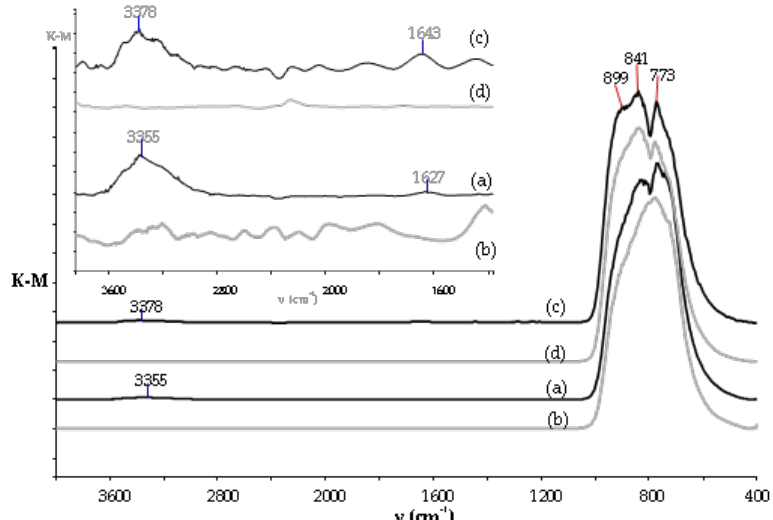
Figure 4. Infrared (IR) spectra (DRIFT) of (a) Ti6Al4V/TNT20/Ar and (c) Ti6Al4V/TNT50/Ar samples (the samples after drying in the Ar stream) and Ti6Al4V/TNT20/Ac (b) and Ti6Al4V/TNT50/Ac (d) the samples immersed in acetone and dried at 396 K by 1 h.